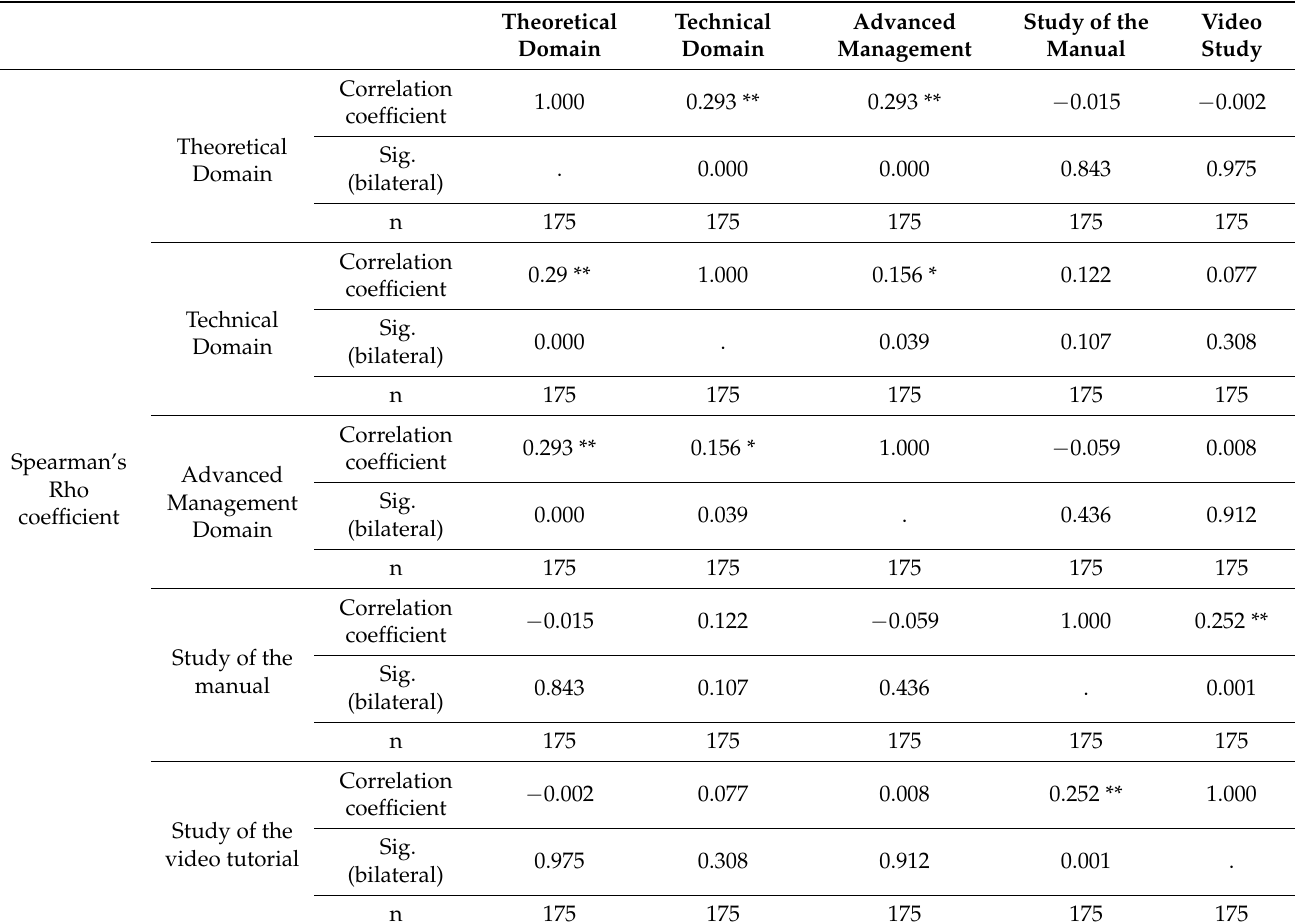
Table 5. Correlations between simulator knowledge/learning variables and resources. Students sample.